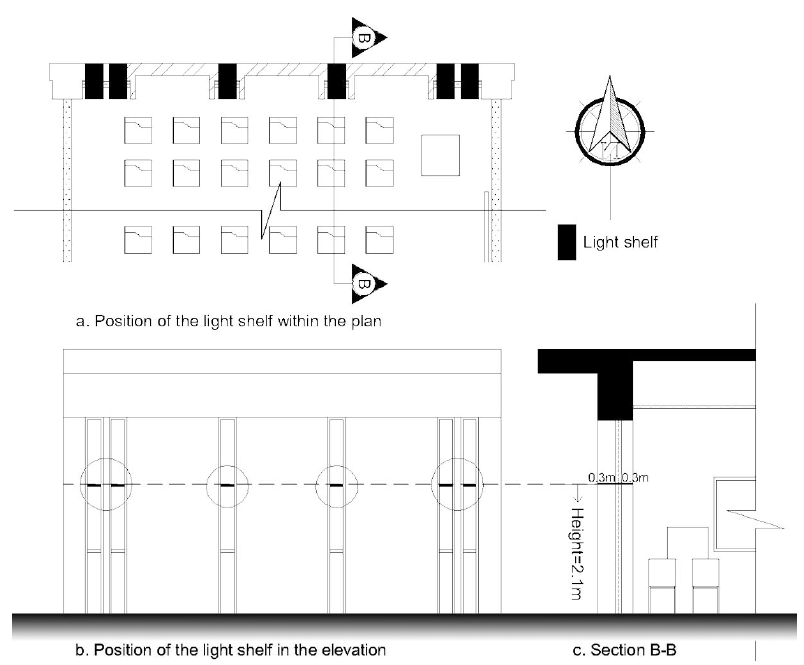
Figure 8. Lightshelves’ location within the plan, elevation, and section of the classroom.